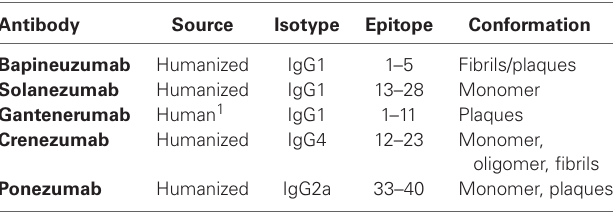
Table 1 | Summary of the most advanced passive immunotherapies for Alzheimer’s disease